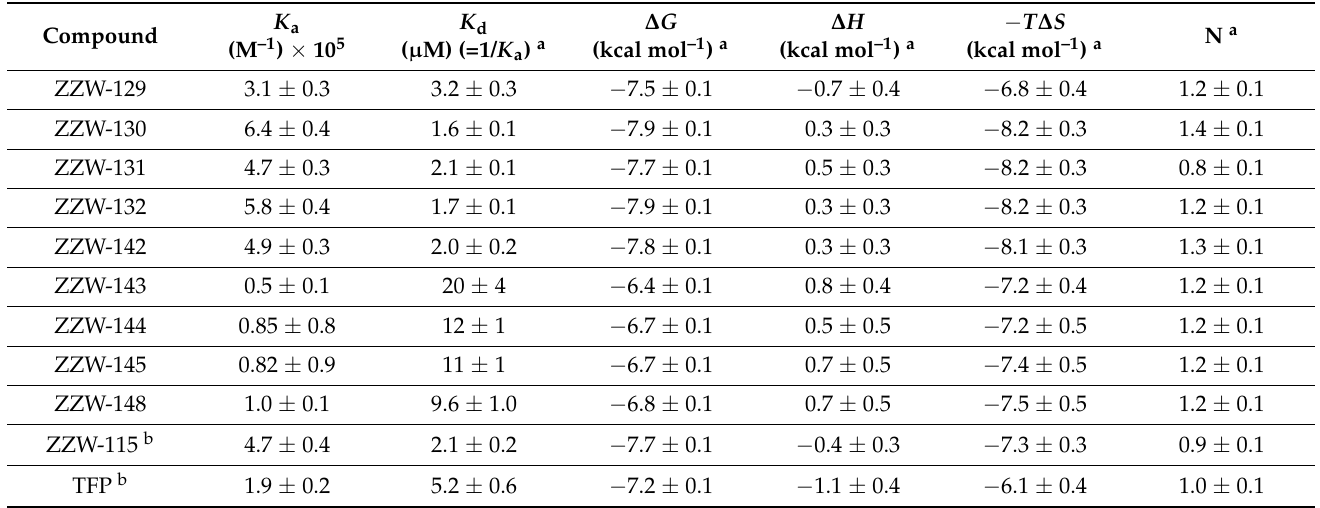
Table 1. Thermodynamic parameters of the binding reaction between NUPR1 and the compounds. a Obtained from ITC measurements; errors are estimated from the fitting and standard thermodynamic relationships ( K d = 1/ K a ; ∆ G = − R T ln K a ; ∆ G = ∆ H – T ∆ S ). b Data taken from